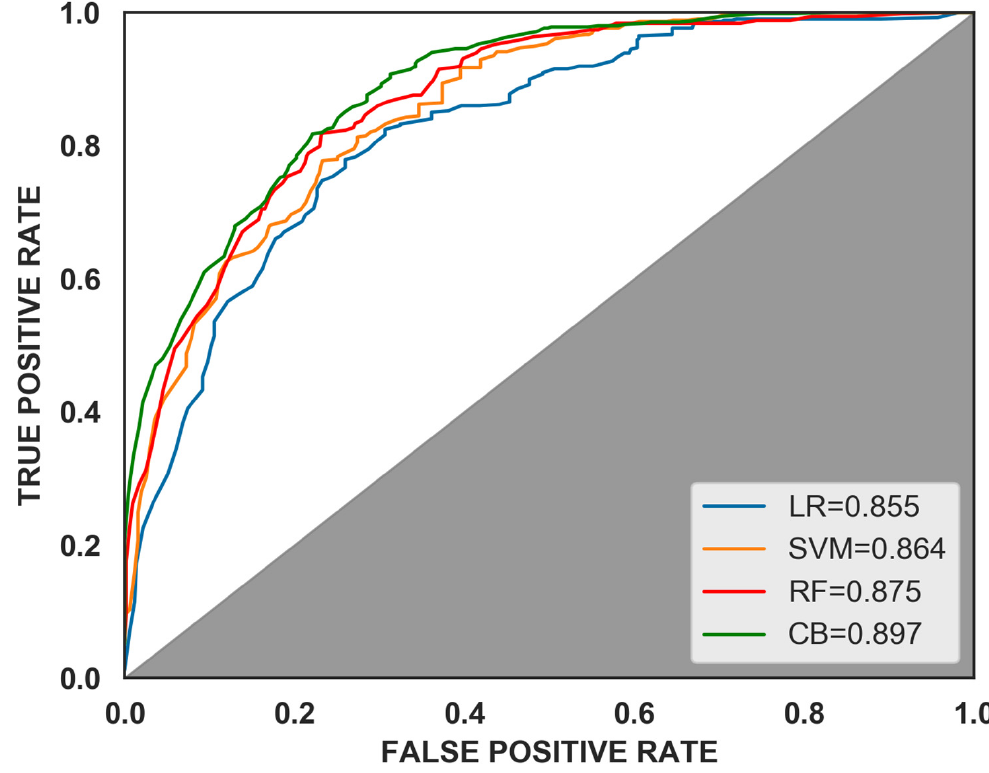
Figure 7. Curve comparison of ROC.